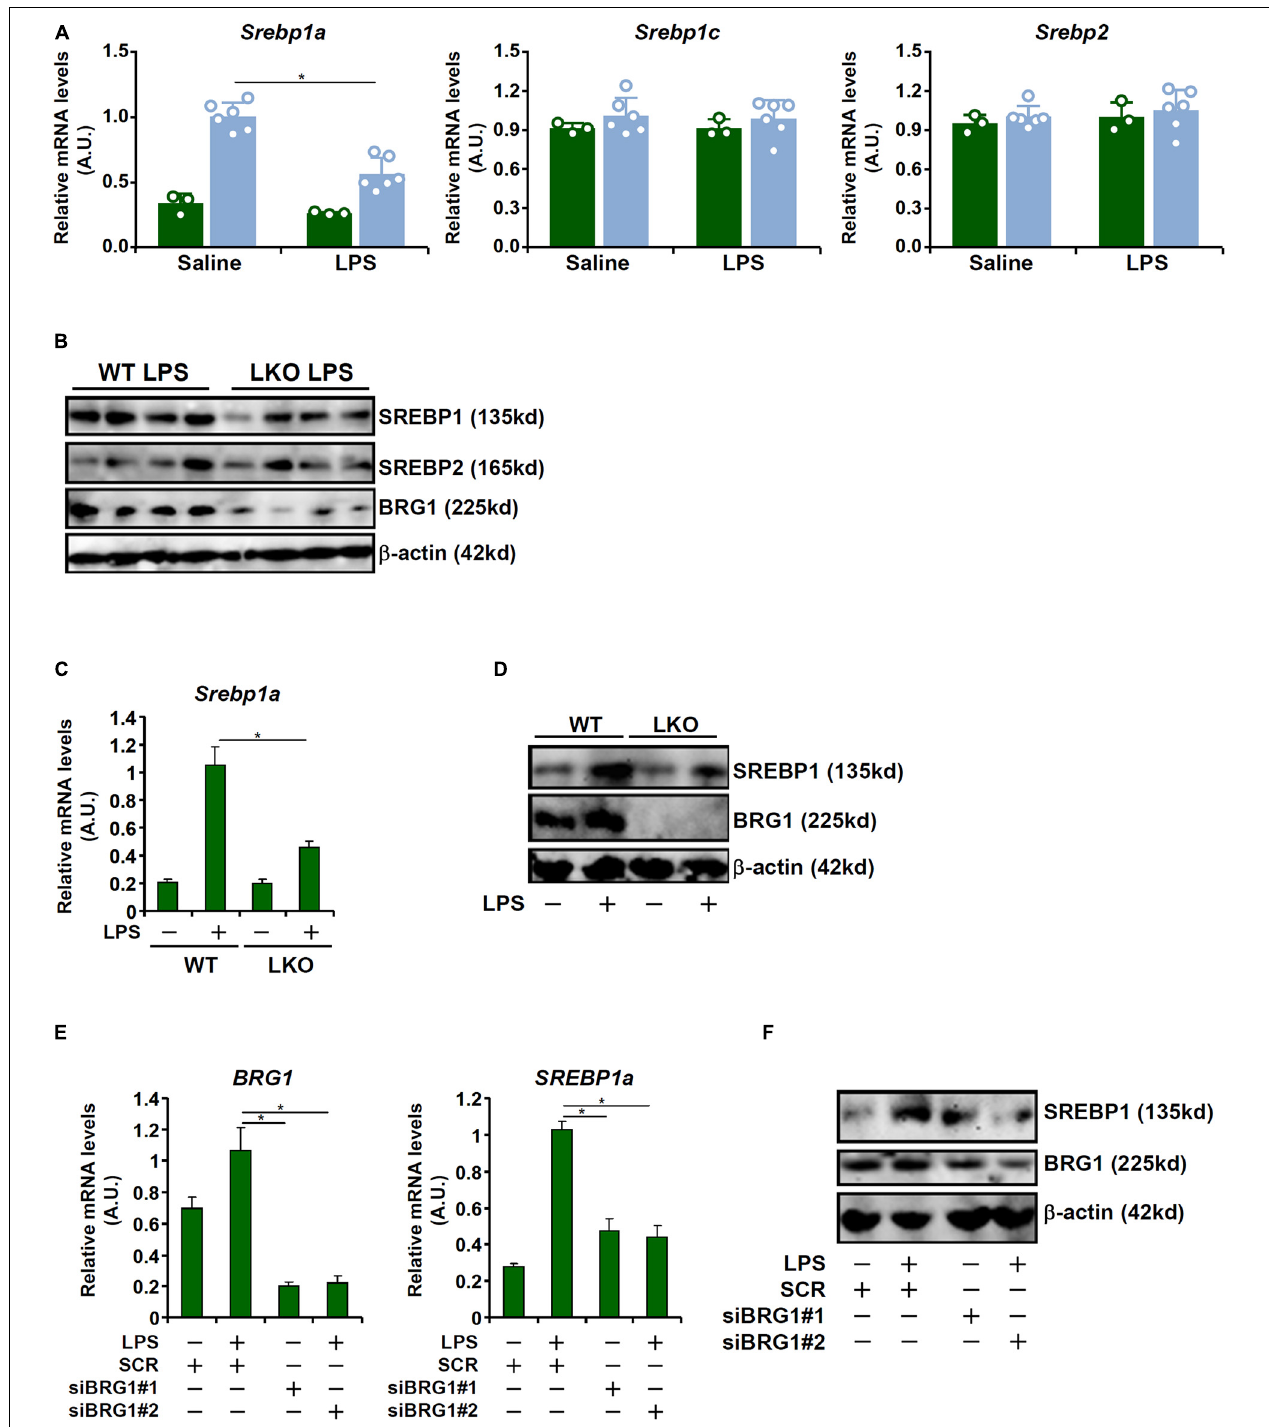
FIGURE 2 | BRG1 deficiency attenuates LPS-induced SREBP1a expression in vivo and in vitro . (A,B) WT and BRG1 LKO mice were injected peritoneally with LPS (15 mg/kg) and sacrificed 24 h after the injection. SREBP expression levels were examined by qPCR and Western. N = 3 mice for the saline groups and N = 6 mice for the LPS groups. (C,D) Primary hepatocytes isolated from WT and BRG1 LKO mice were exposed to LPS (1 µ g/ml) for 12 h and SREBP1a expression was examined by qPCR and Western. (E,F) HepG2 cells were transfected with siRNA targeting BRG1 or scrambled siRNA (SCR) followed by treatment with LPS (1 µ g/ml) for 12 h and SREBP1a expression was examined by qPCR and Western.